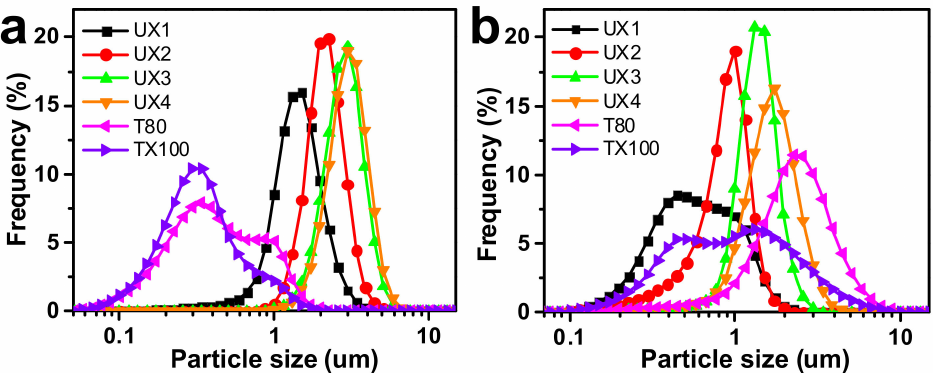
Figure 5. Particle size distribution of emulsions with ( a ) 0.5 wt% and ( b ) 2 wt% emulsifiers.